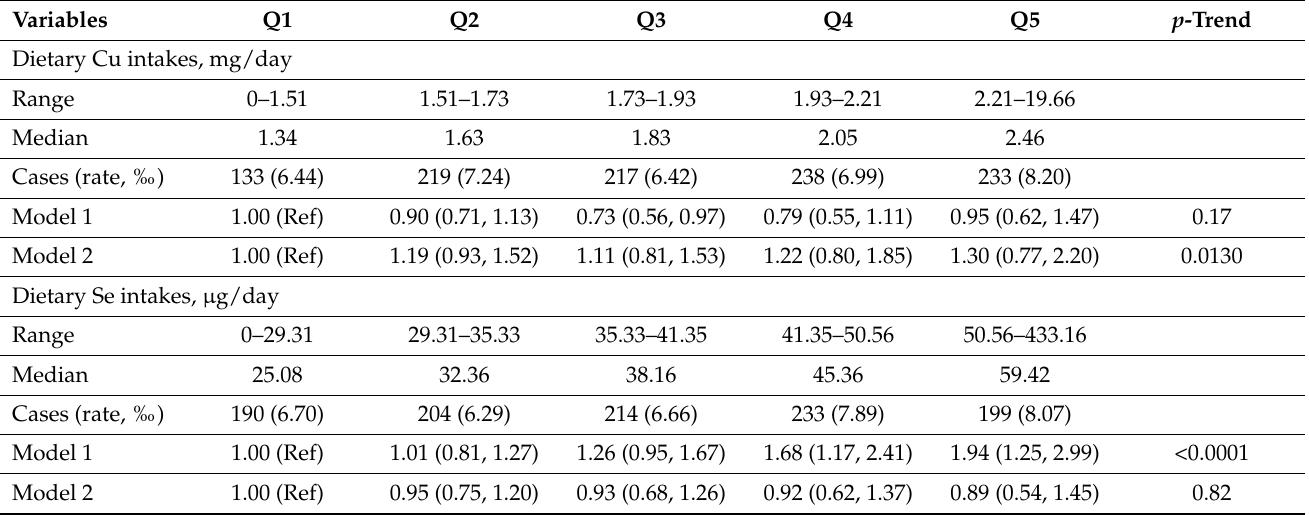
Table 3. HRs and 95% CIs for T2DM risk associated with quintiles of dietary Cu and Se intakes in 14,711 Chinese adults of the China Health and Nutrition Survey, 1997–2015 1